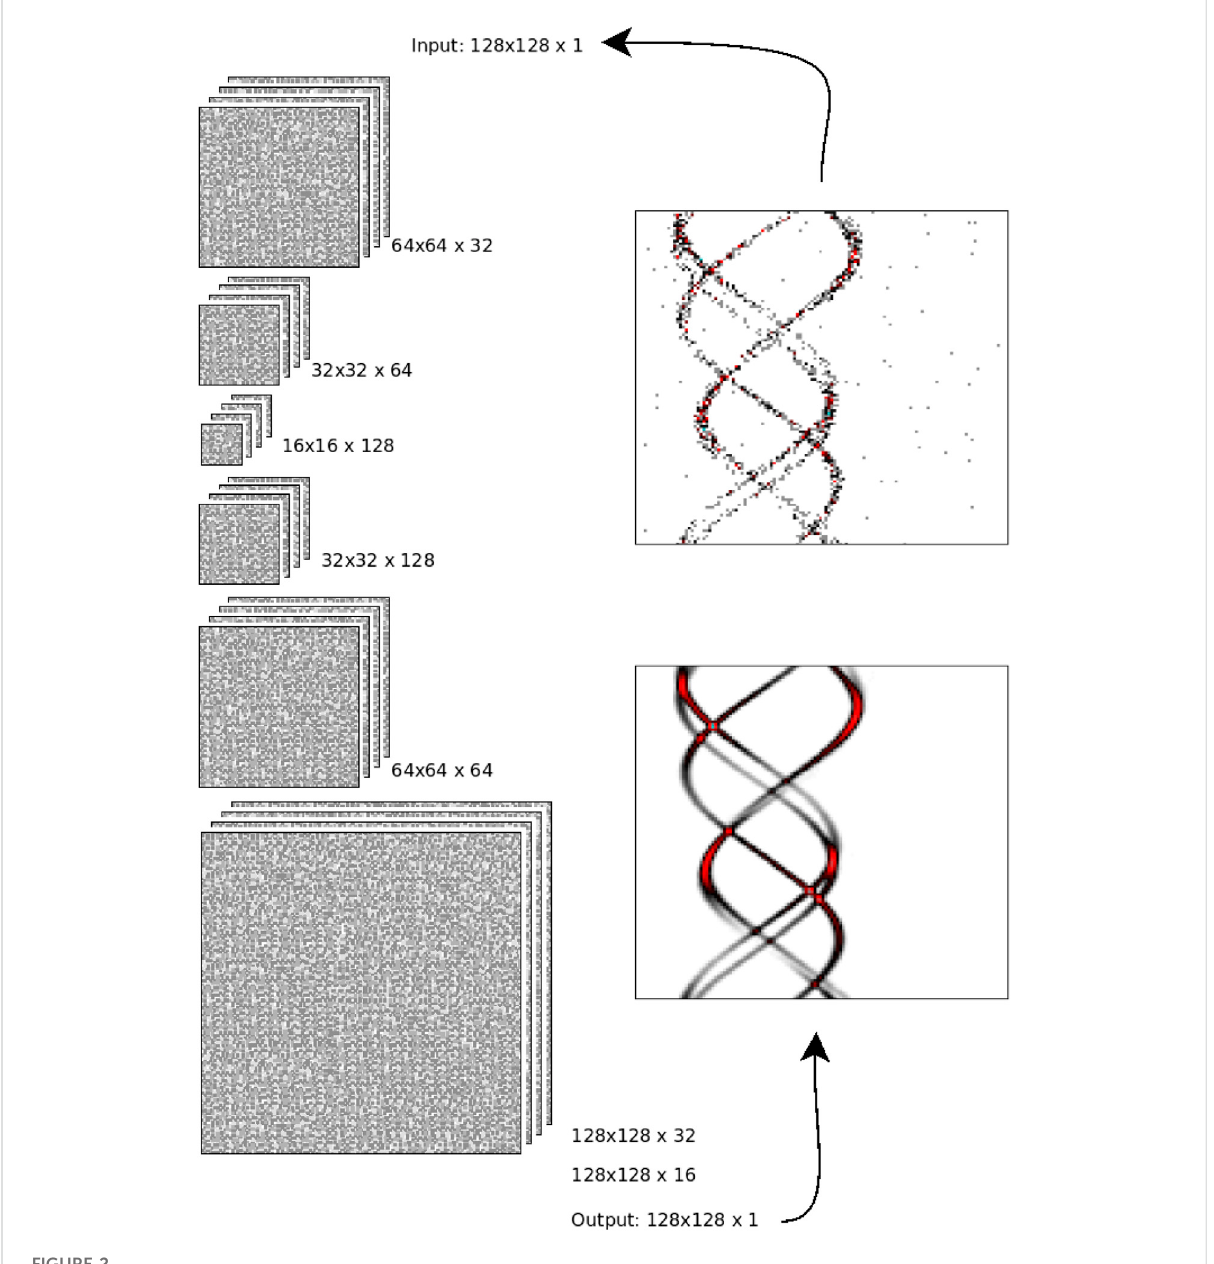
FIGURE 2 Schematic of the encoder – decoder